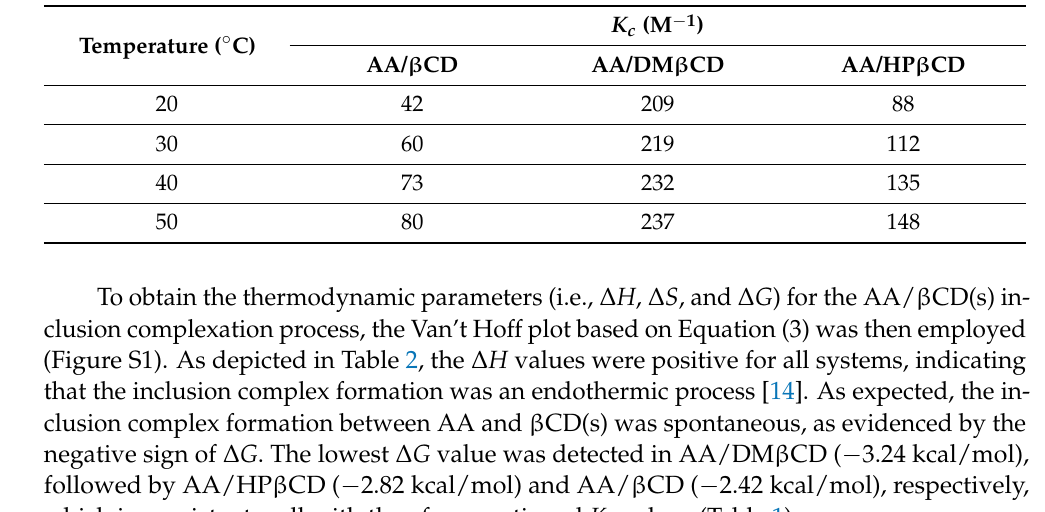
Figure 2. Phase solubility diagrams of AA in complex with β CD, DM β CD, and HP β CD at 20 °C, 30 °C, 40 °C, and 50 °C. Data are expressed as mean ± SEM of three independent experiments. Table 1. Stability constant ( K c ) of the AA/ β CDs inclusion complexes at different